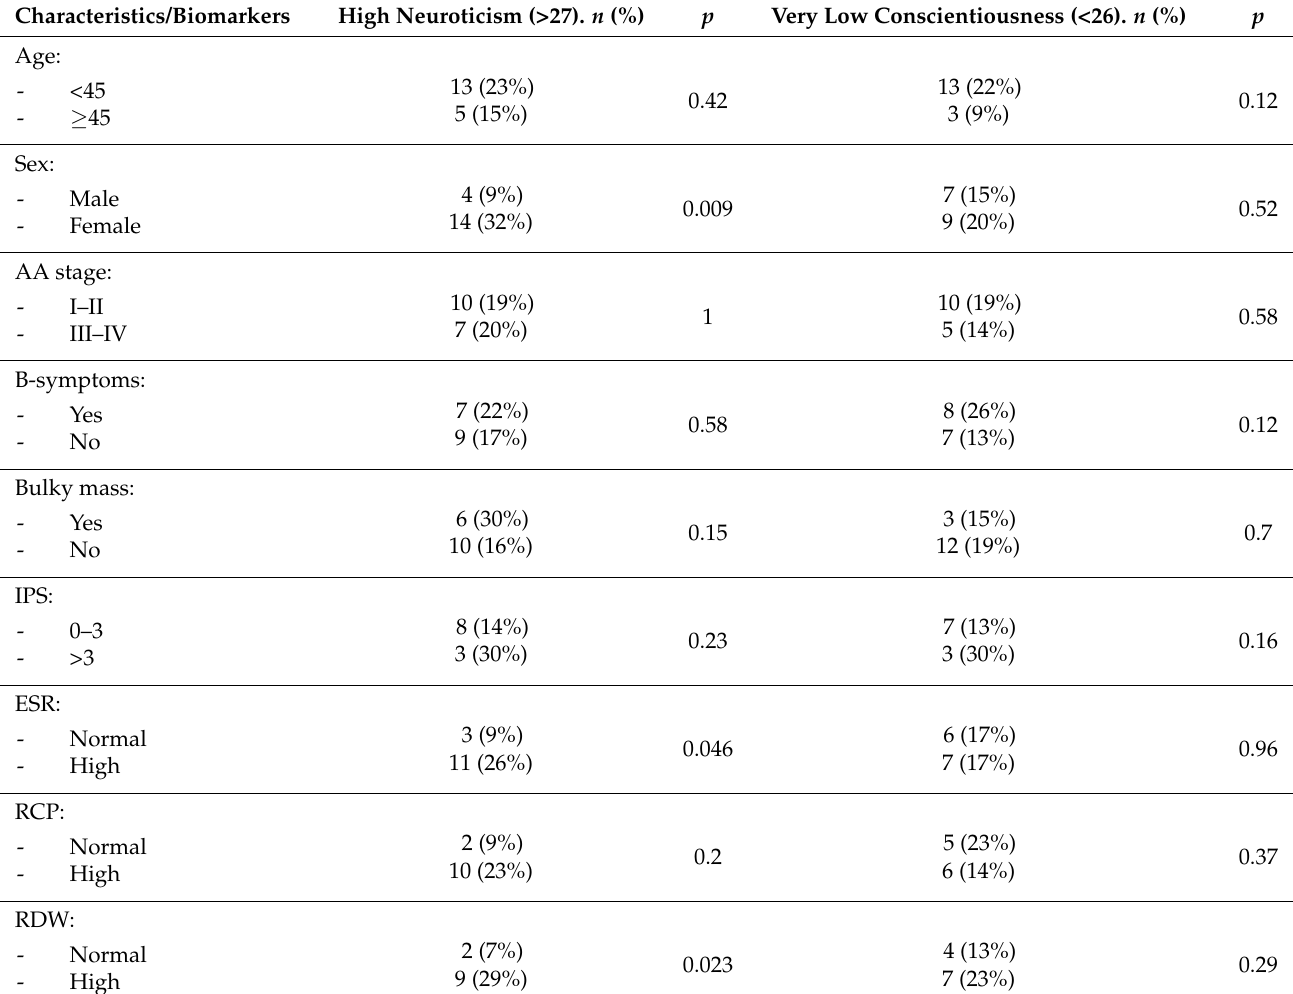
Table 6. Personality traits and clinical characteristics/biomarkers in